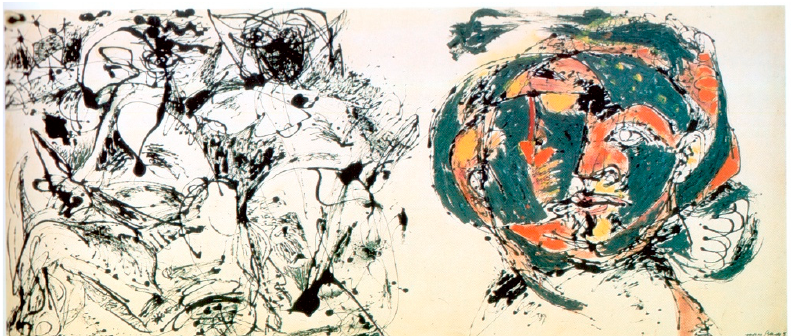
Figure 25. Jackson Pollock, Portrait and a Dream , 1953. Oil on canvas, 148.59 cm × 3 m 42.26 cm, Dallas Museum of Art. Gift of Mr. and Mrs. Algur H. Meadows and the Meadows Foundation, Incorporated. © 2022 The Pollock-Krasner Foundation/Artists Rights Society (ARS), New York. In the panel on the right is a self-portrait when he was not sober as he said to a friend, one eye of his head barely hinted at, buried in a gray field struck through by a downward- pointing red arrow (Landau 1989, pp. 217–18). This simulated blinding is accompanied on the left panel done in the black and white style begun in 1951 by the “dream”. There, we see in the upper left the head of a humanoid creature facing left; it holds a distinctive dagger visible on the middle-left edge of the canvas, its aggressive presence reinforced by the upward diagonal leading towards it. To Lee Krasner, he explained that the upper right-hand corner of the left panel had to do with “the dark side of the moon”. 58 There, we see clearly an upturned crescent on top of which Pollock made effacing black